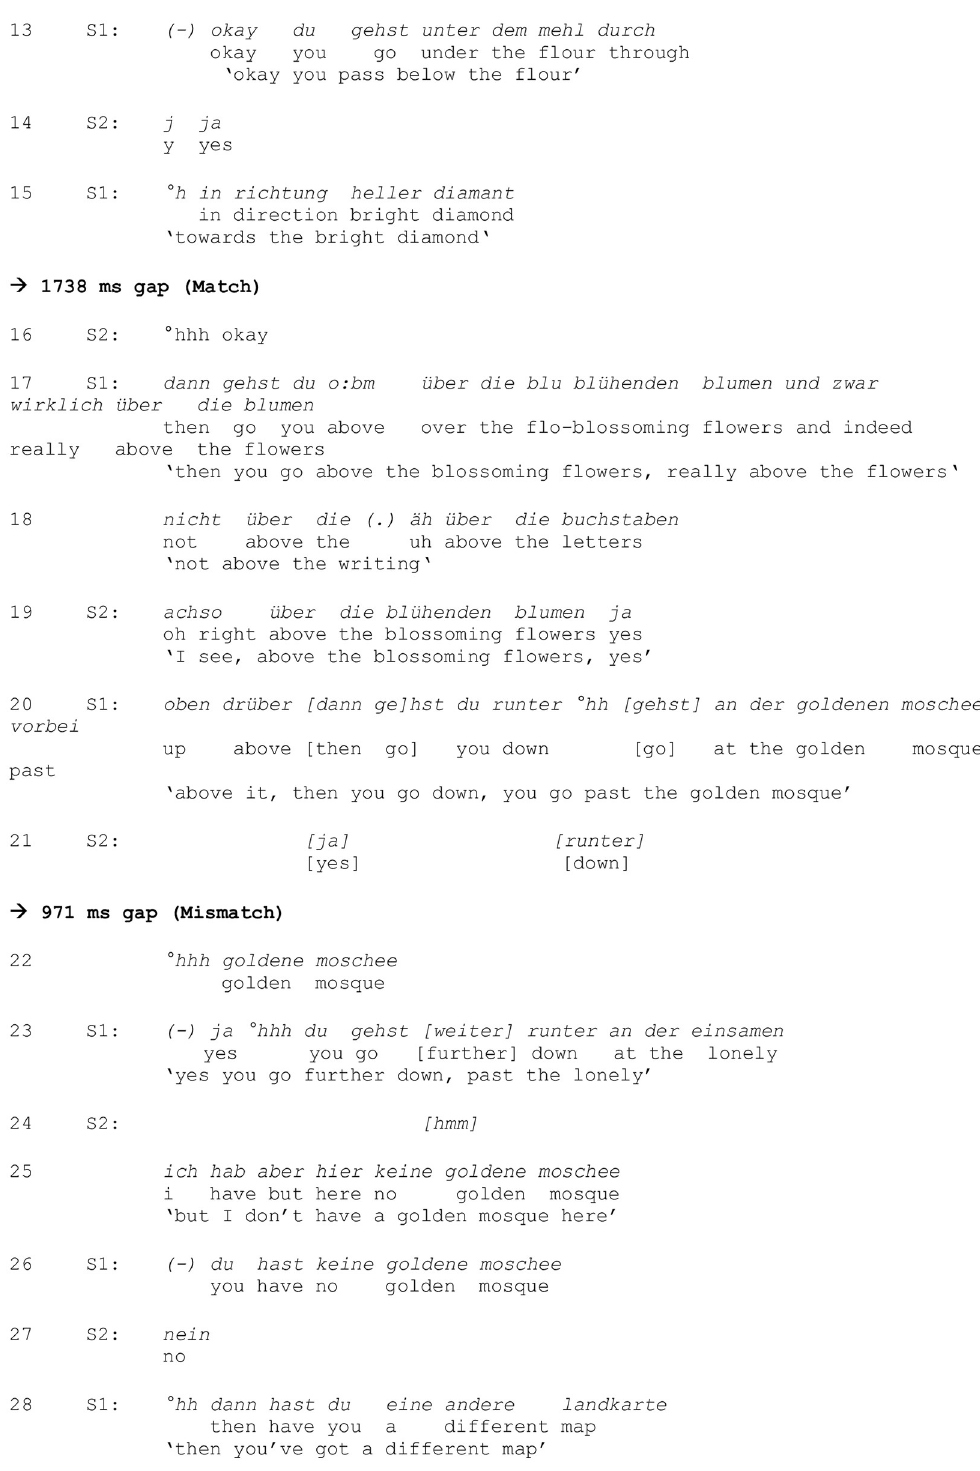
Fig 2. Example excerpt of a GAT transcription. Two turn transitions (following newly introduced landmarks) are highlighted in bold (lines 15/16; 21/22).